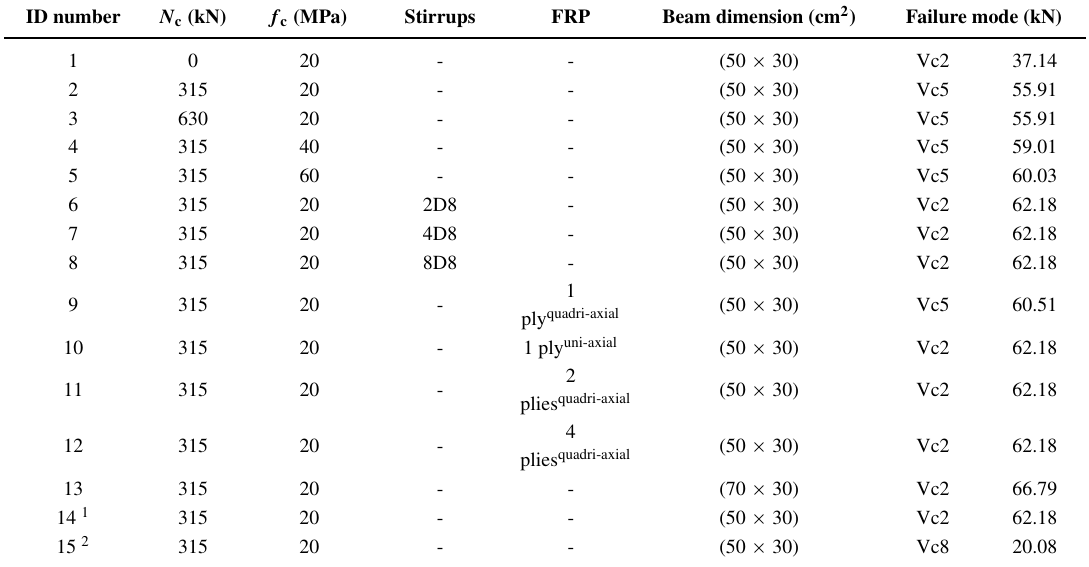
Table 2. Parametric analysis: variability of considered parameters; failure modes and column shear capacities of considered joint